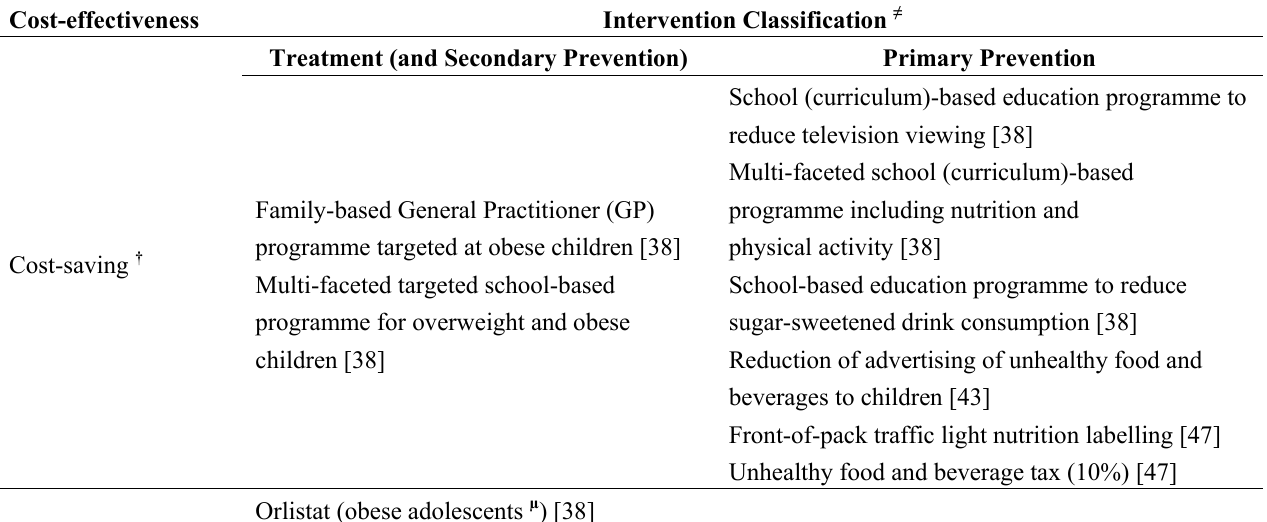
Table 1. Cost-effectiveness of primary prevention versus treatment (and secondary prevention) interventions from the Assessing Cost-Effectiveness (ACE)-Obesity and ACE-Prevention